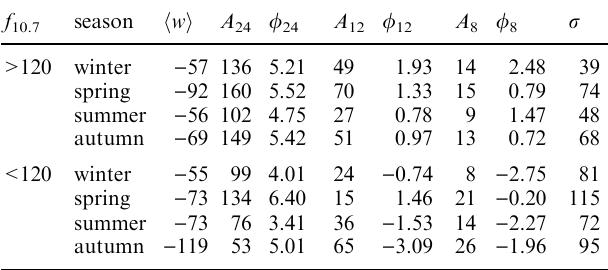
Table 10. Harmonic decomposition at 282 km height f 10.7